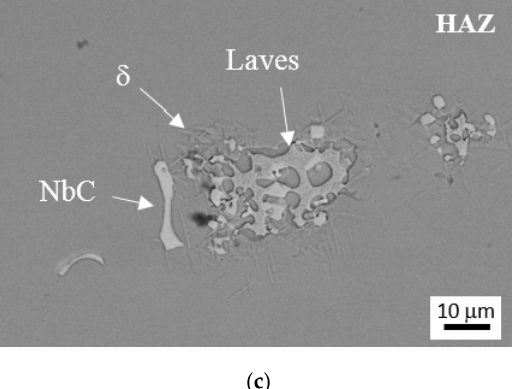
Figure 13. ( a ) Phases in the interdendritic region. ( b ) Magnification of the squared zone showing the presence of δ phase, carbides, and Laves phases in base metal (BM) in the interdendritic segregation area. ( c ) Segregation area with evidence of Laves and δ phase liquation in HAZ (NP- less than 3 mm plate).